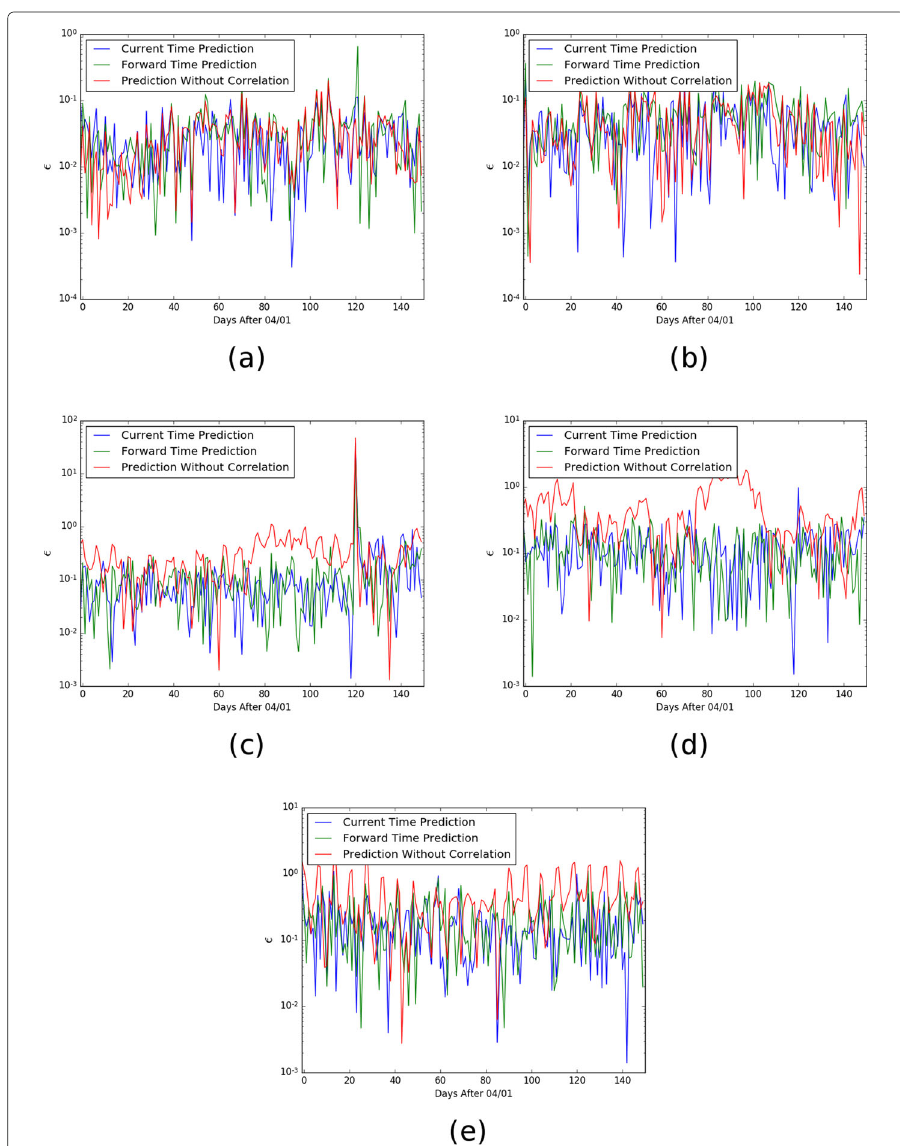
Fig. 4 Each day in the data set is predicted after collecting a sufficient number of days for prediction. We measure the accuracy using the MAPE ( (cid:11) ). a Shows the predictions for Twitter, b for Reddit, c for GitHub, d for Bitcoin, and e for Ethereum. Both methods for predictions are compared against the prediction without correlation and the average MAPE value can be seen in Table 1